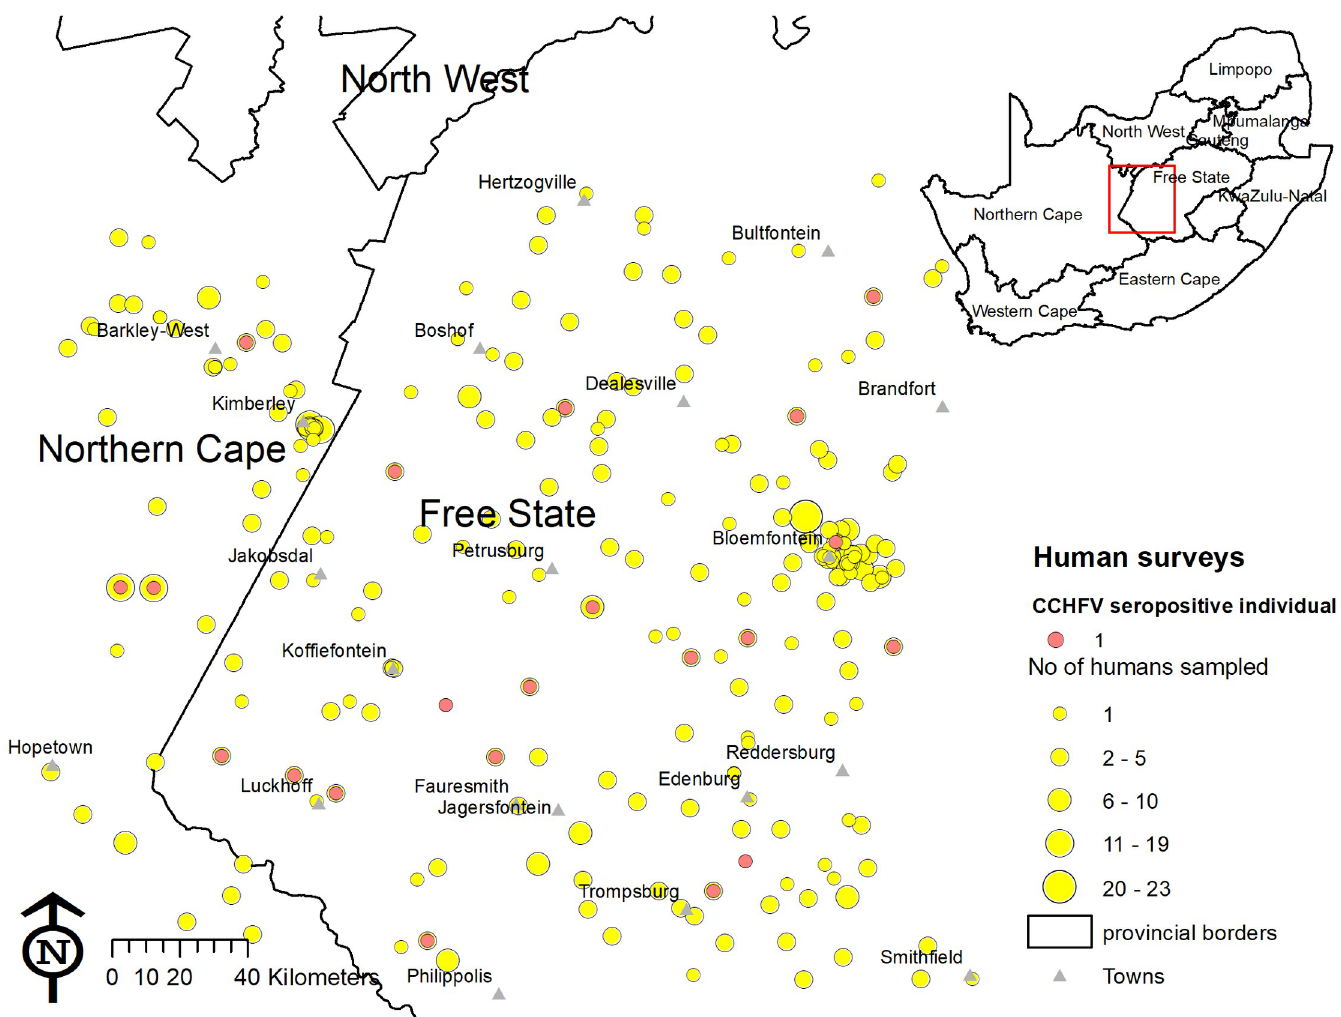
Fig 3. Distribution of individuals seropositive to Crimean-Congo haemorrhagic fever virus among farm workers, veterinary and wildlife personnel in central South Africa, 2017–2018. Yellow circles indicate number of people sampled and red dots show seropositive individuals. The map was constructed for the manuscript in Esri ARCGIS 10.2 using country and provincial boundaries from Municipal Demarcation Board [23] and National Geo-Spatial Information [24], coordinates of sampling sites and towns collected during the survey data available under a Creative Commons Attribution (CC BY 4.0) license.